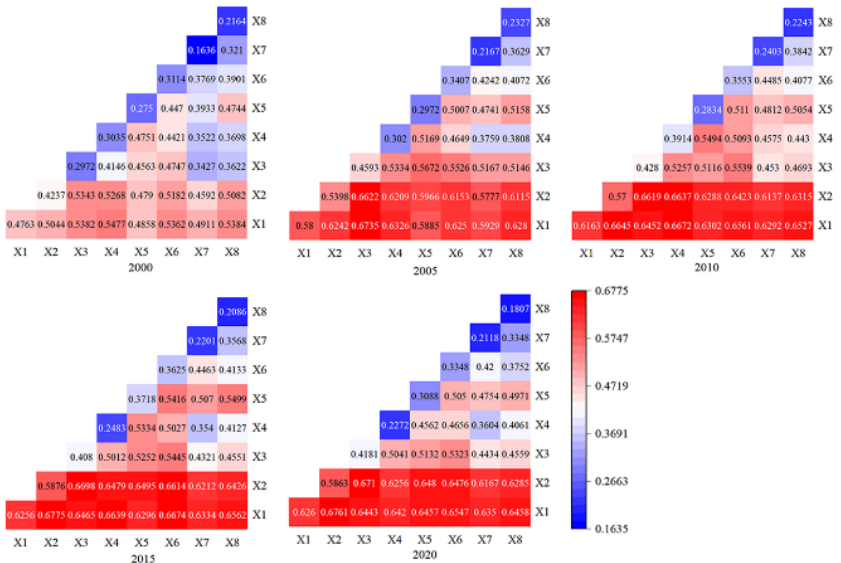
Figure 6. Interaction detection map for each factor.